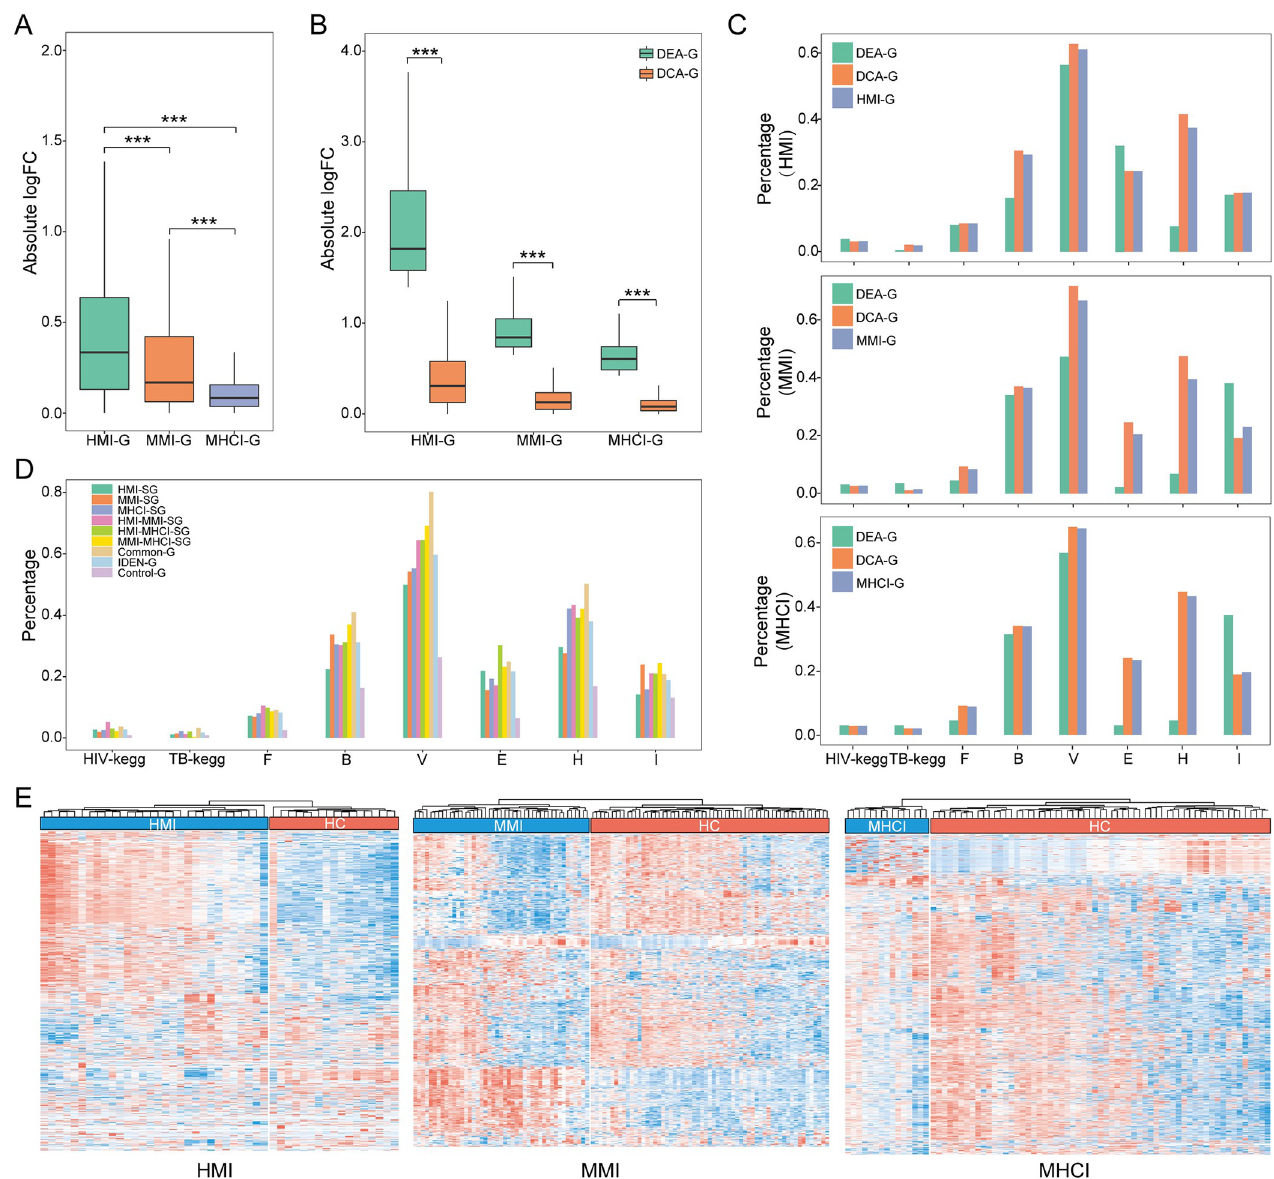
Fig 3. Advantage and confidence of IDEN framework. (A) Expression change of identified genes. (B) Expression change of genes identified by the DCA and DEA methods. (C) Enrichment of genes identified by the DCA and DEA methods in the important gene sets. F, B and V denote human targets for fungi, bacteria and viruses, respectively, and E, H and I denote essential genes, housekeeping genes and inflammatory genes, respectively. (D) Enrichment of the subclasses of IDEN-G in the important gene sets. (E) Clustering analysis of disease and healthy samples. The rows denote disease-related genes (red: up- regulated and blue: down-regulated) and the columns denote samples. ��� P < 0.001, �� 0.001 � P < 0.01 and � 0.01 � P <